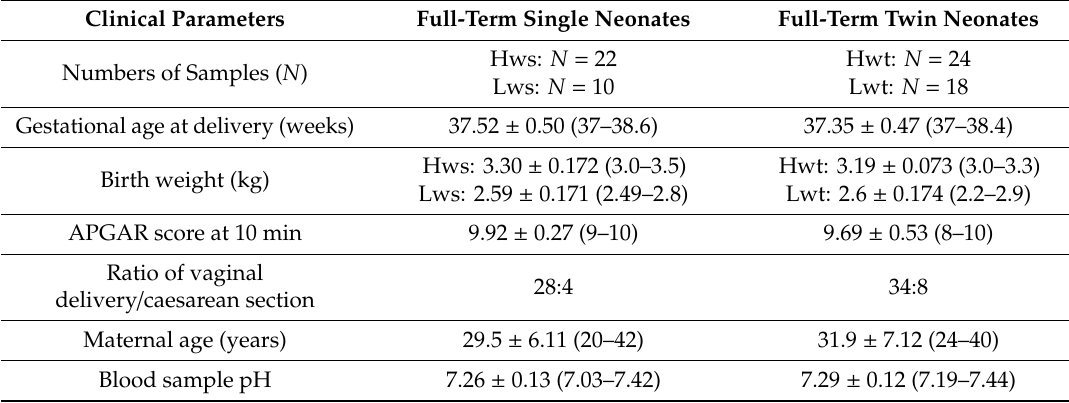
Table 1. The clinical parameters of the study groups and the maternal